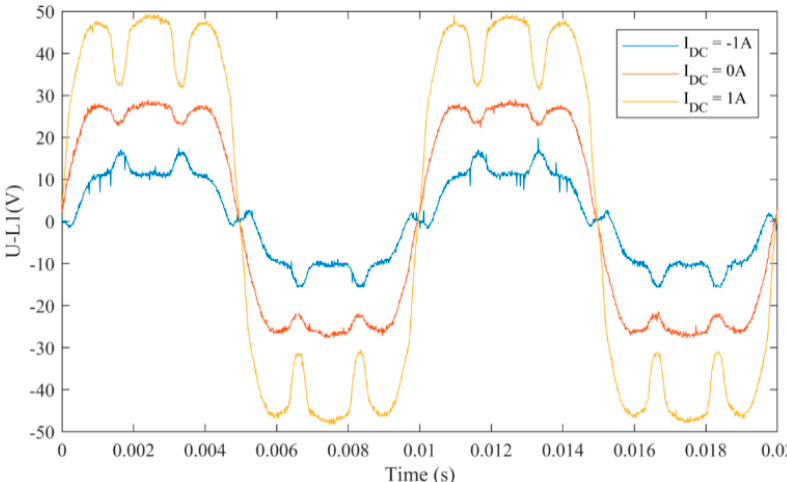
10 of 12 Figure 15. Experimental and 3D-FEA results of back-EMF characteristics versus DC control coil current. Table 2. Comparison of 3D-FEA predictions and experimental results of no-load back-emf (RMS).